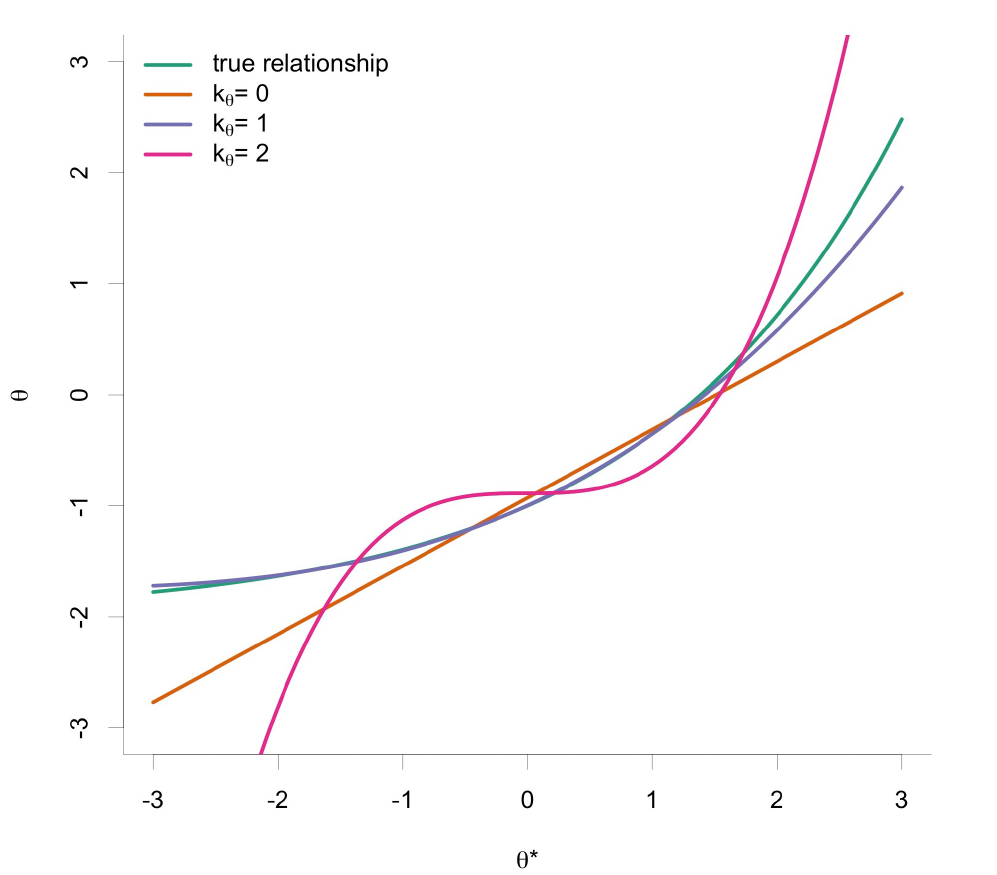
Figure 3. True linking transformation and estimated Stocking–Lord linking transformations with various k θ